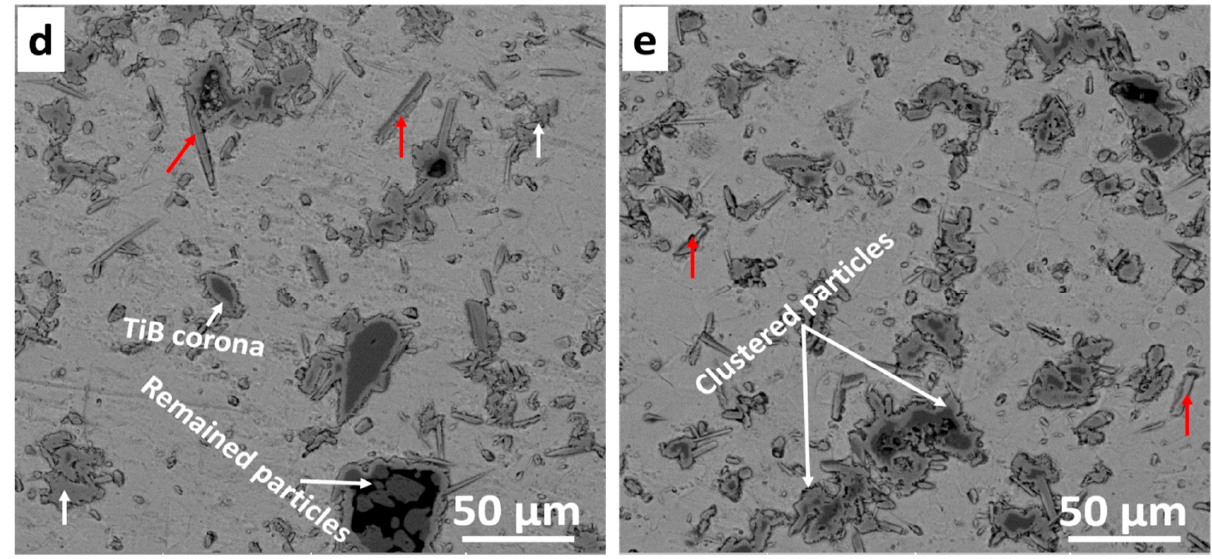
Figure 6. Secondary electron images of sintered samples ( a ) T0.0, ( b ) T2.5, ( c ) T5.0, ( d ) T7.5 ( e ) T10.